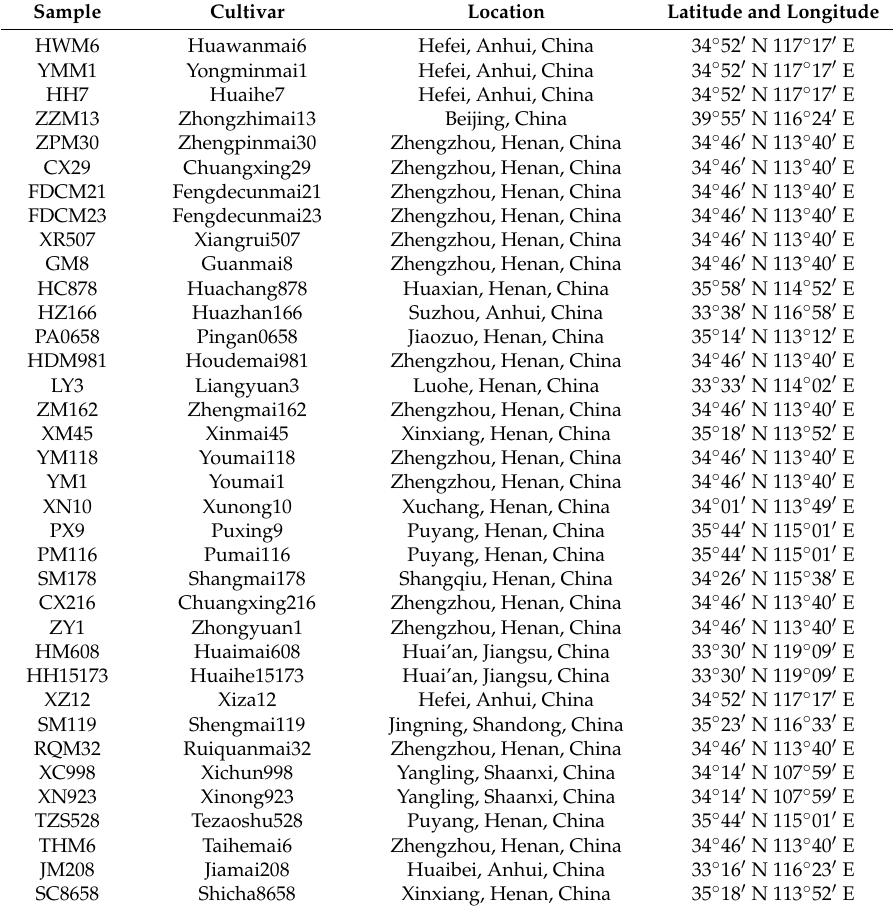
Table A1. Corresponding information of 36 wheat samples.